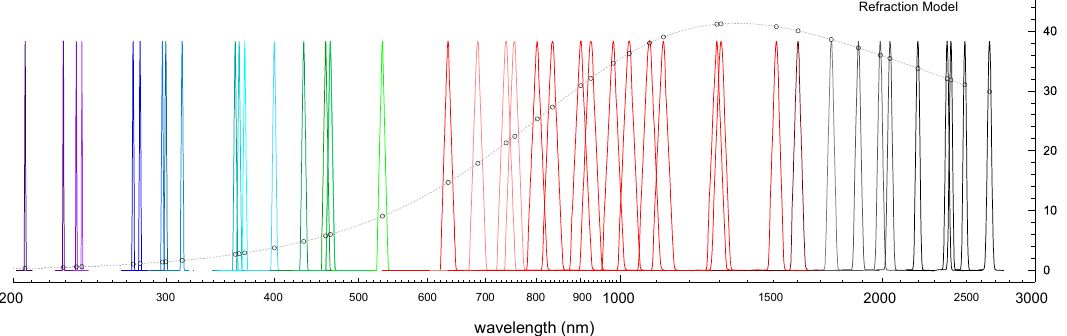
Figure 8. Full spectrum measurement of the SIM spectral response functions from the UV (206 nm) out to the shortwave IR (2700 nm). The instrument function for each wavelength was measured for both laser polarizations (orthogonal s and p), and nine separate field of view (FOV) angles (on-axis, and ± 10, ± 20 arc-min in both dispersion and cross-dispersion directions). These provided a direct measurement of the spectral resolution and allowed for further refinement of the full optical refraction model, including FOV and o ff -axis pointing optical model